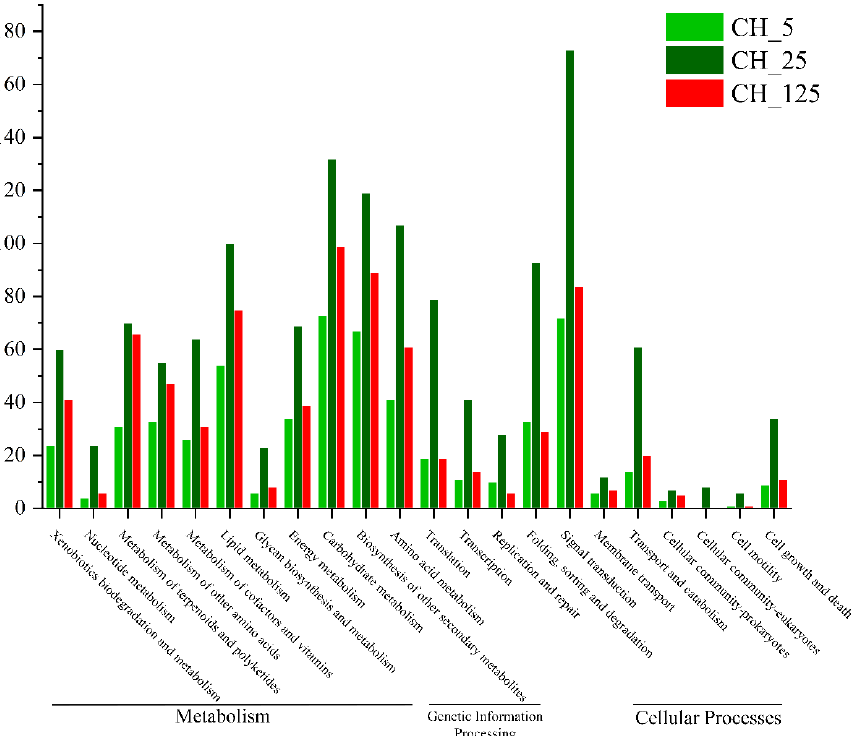
Figure 8. Kyoto Encyclopedia of Genes and Genomes (KEGG) analysis of differentially expressed genes in three different concentrations of N-(2-chloro-4-pyridyl)-N’-phenylurea (CPPU) treatment (5 mg · L − 1 , 25 mg · L − 1 , and 125 mg · L − 1